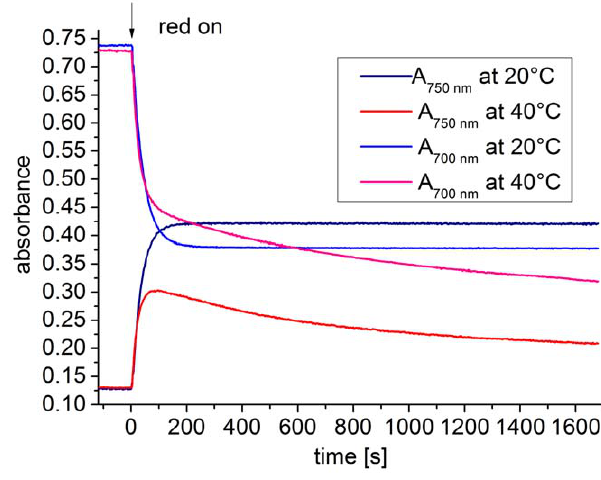
Figure 6. Photoconversion of Agp1 at 20 6 C and 40 6 C. Measurements were performed at 700 nm and 750 nm. At t=0, red light (655 nm, 20 m mol m 2 2 s 2 1 ) was switched on.